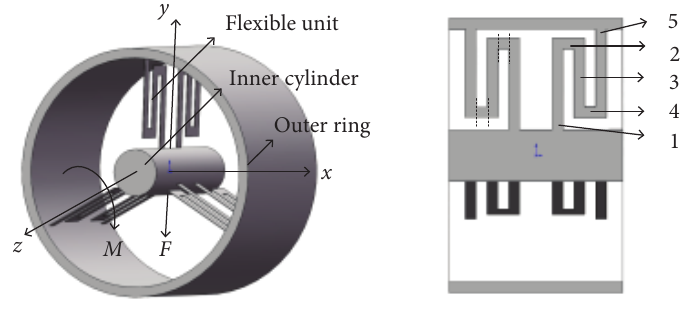
Figure 2. The structure of fl exure